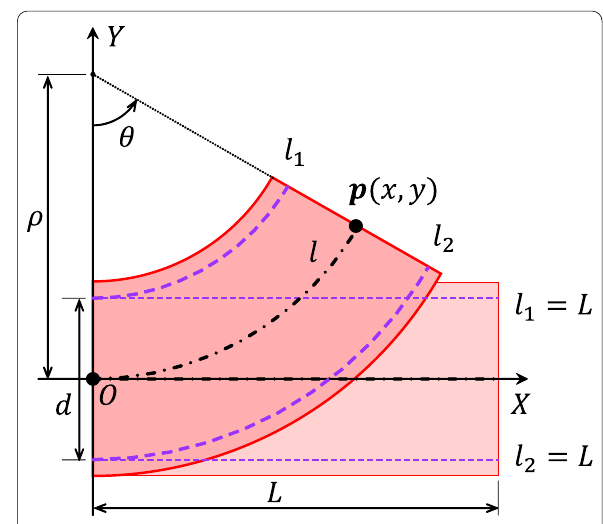
Fig. 5 Deformation model of the planar mechanism with two degrees-of-freedom input. The light pink part shows the natural state, and the dark pink part shows the deformation state when the wires are